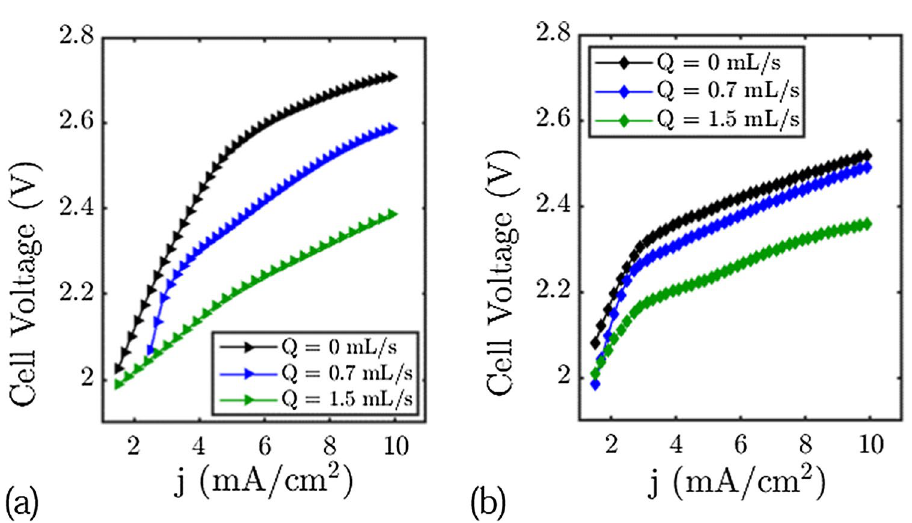
Figure 2. Cell Voltage of the electrolysis cell and the Zinc cell setup for different flow rates. ( a ) Electrolysis cell. ( b ) Zn-cell